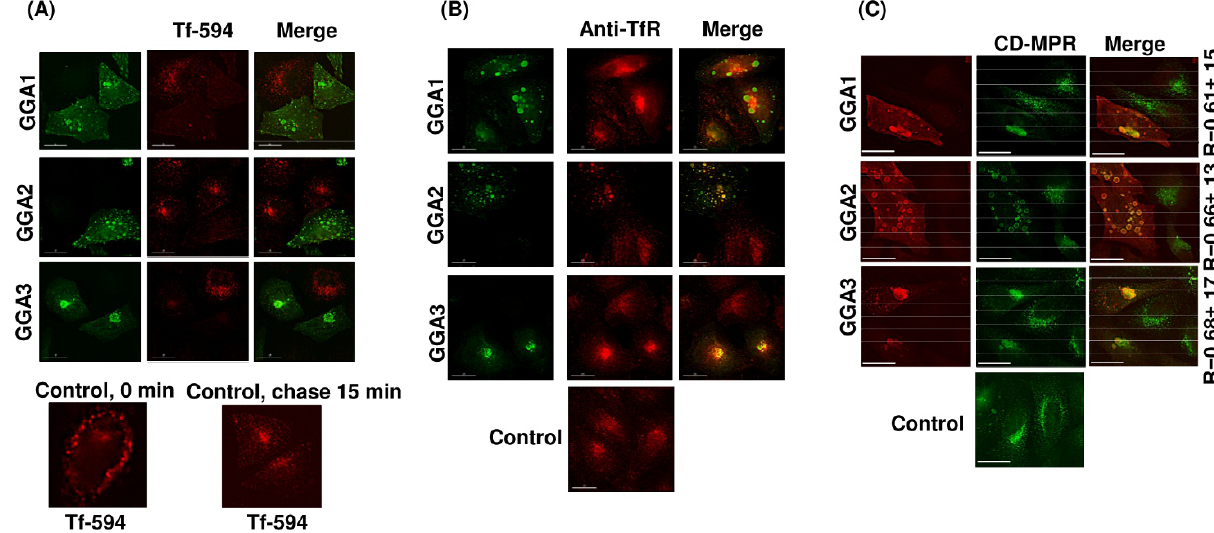
GGA overexpression perturbs cellular sorting pathways Figure